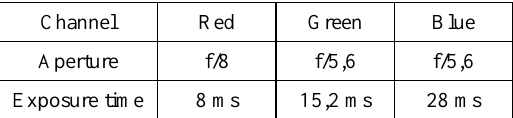
Table 1. Aperture and exposure time for each channel